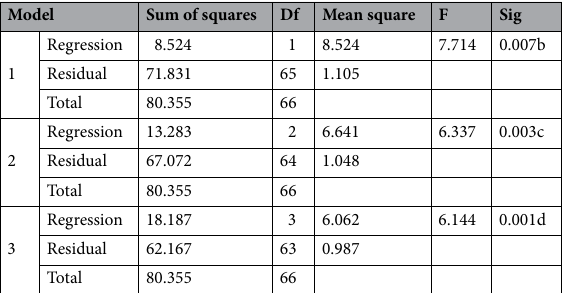
Table 4. ANOVA table for stepwise regression models adjusted for the dependent variable T score of the hip. a. Dependent variable: T score hip. b. Predictors: Age. c. Predictors: Age, Testosterone levels (ng/mL). d. Predictors: Age, Testosterone levels (ng/mL), Body mass index (Kg/m2).